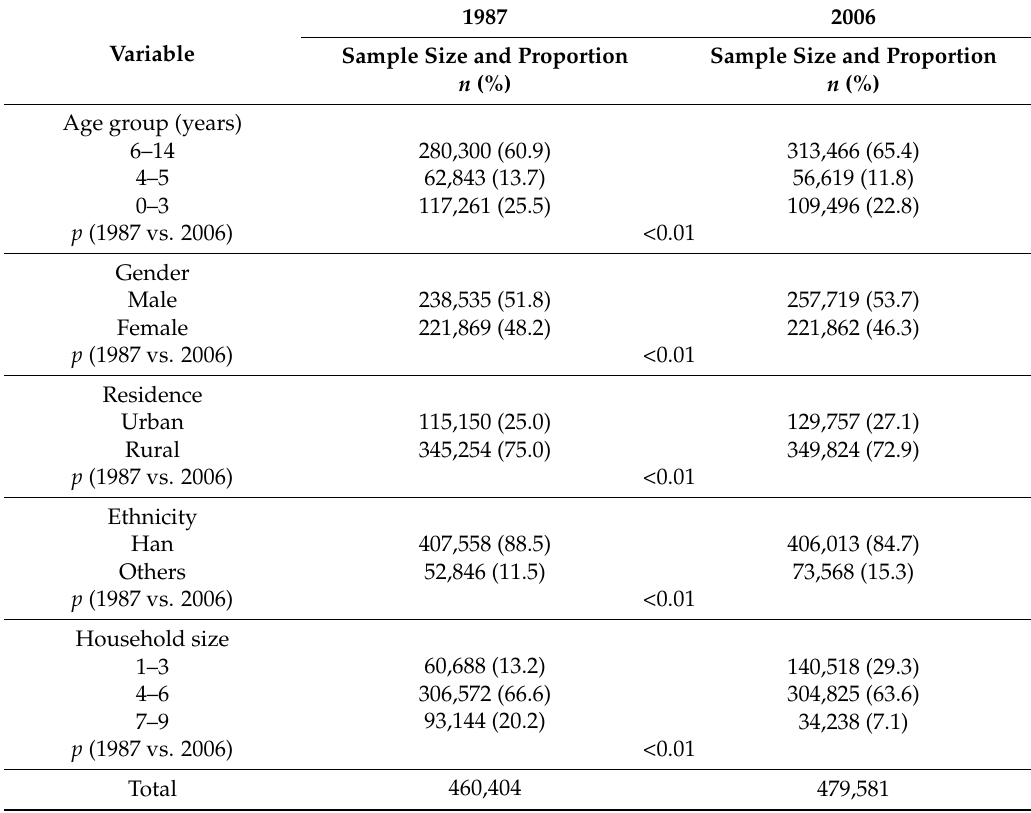
Table 3. Characteristics of psychiatric disability and associations with demographic in Chinese children